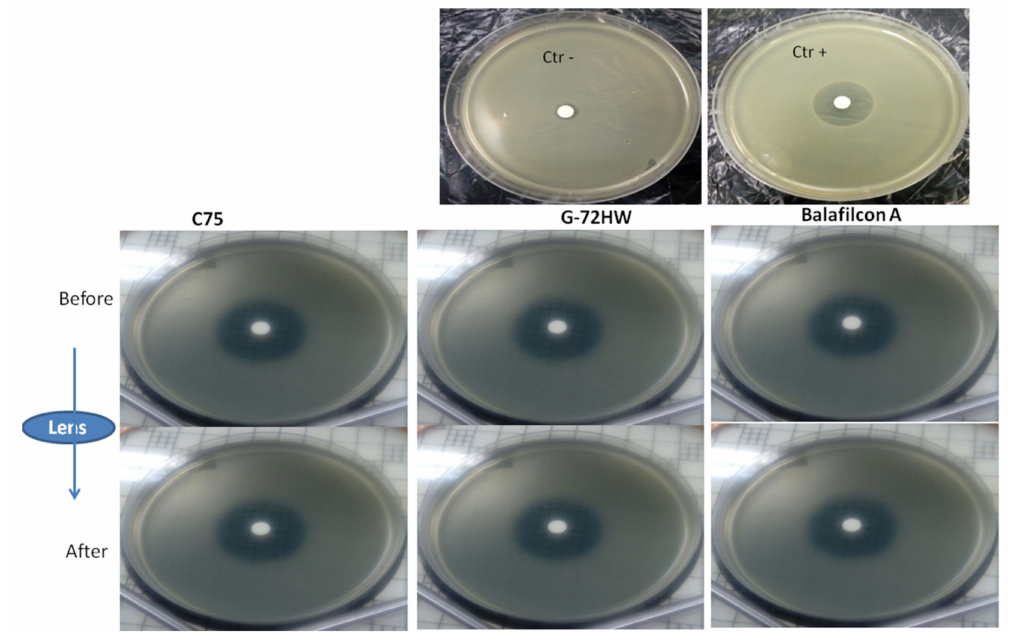
Figure 4. Inhibition of Salmonella typhimurium growth by chloramphenicol after interaction with different lens types. Inhibition effectiveness was measured according to the diameter of the zone of